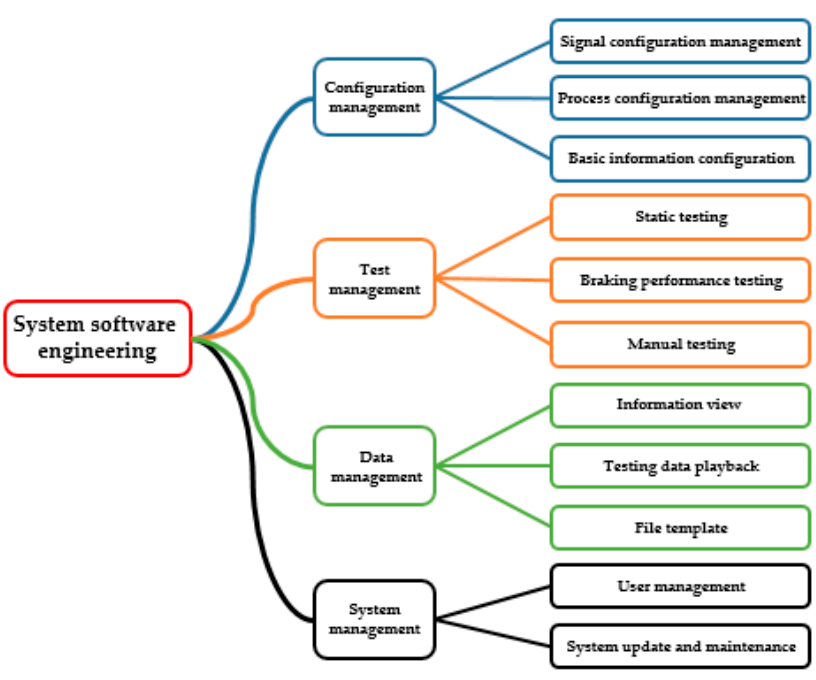
Figure 3. Structure of system software.